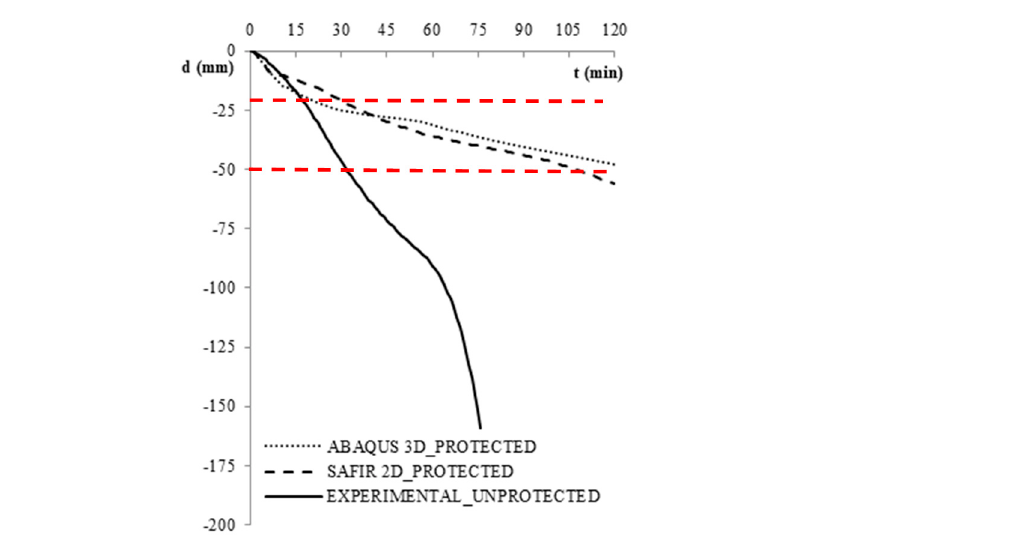
Figure 13. Effectiveness of Intumescent Coating: predicted deflection for protected slim floor vs. recorded deflection for the unprotected slim floor, WFRC 67756.